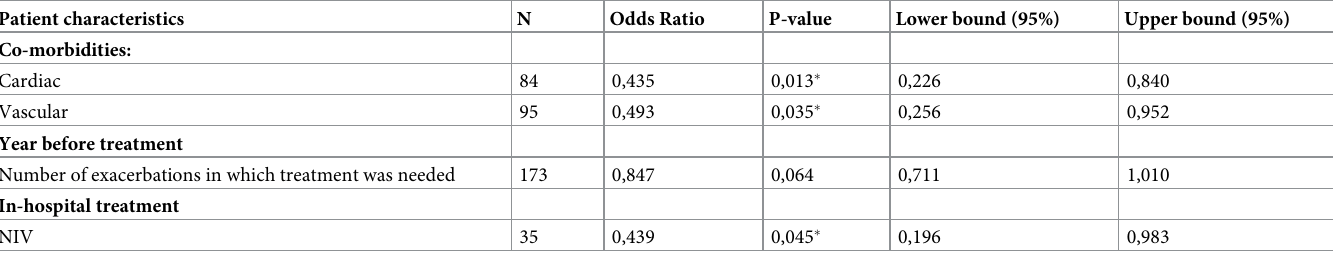
Table 5. Multivariate logistic regression